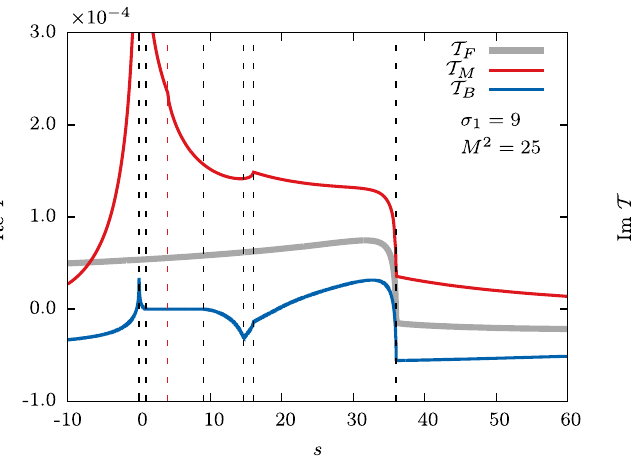
(cid:3) σ ( th ) − m ) 2 = 1 ( T T diverge), s = ( B is singular and M is reg- 3 (cid:3) 3 + m ) 2 = 9, the crossing of the RPE cut at σ ( th ) ular), s = ( 3 3 √ = 9 and M 2 = 25. = 14 . 64, the initial state threshold s = ( σ + m ) = 16, s = s ( 0 ) 1 1 1 31 and the normal threshold singularity at s = ( M + m 3 ) 2 = 36. The red √ σ − m ) 2 = 4 dashed line indicates the pinch singularity at s = ( 1 1 ) makes T T B and M that occurs only in T M 3